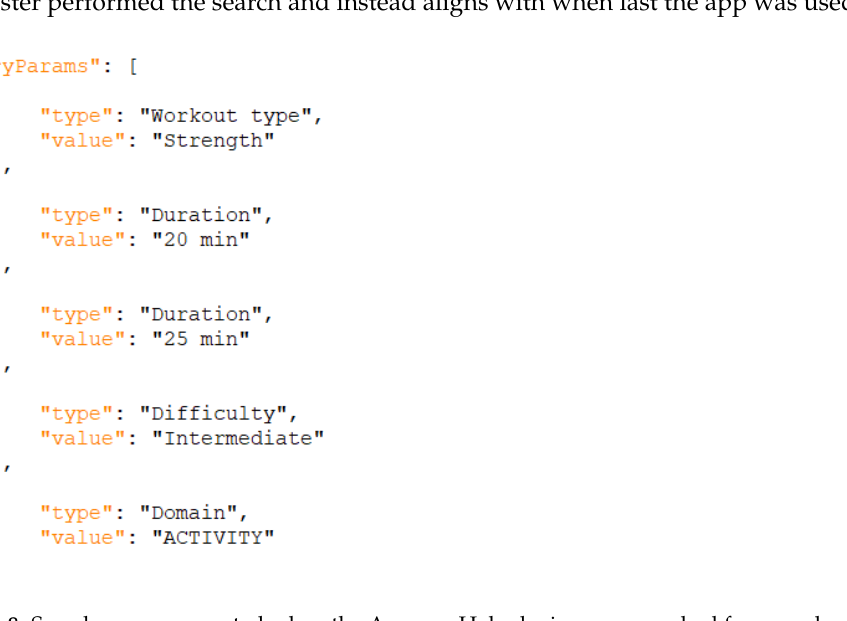
Figure 8. Search query generated when the Amazon Halo device user searched for a